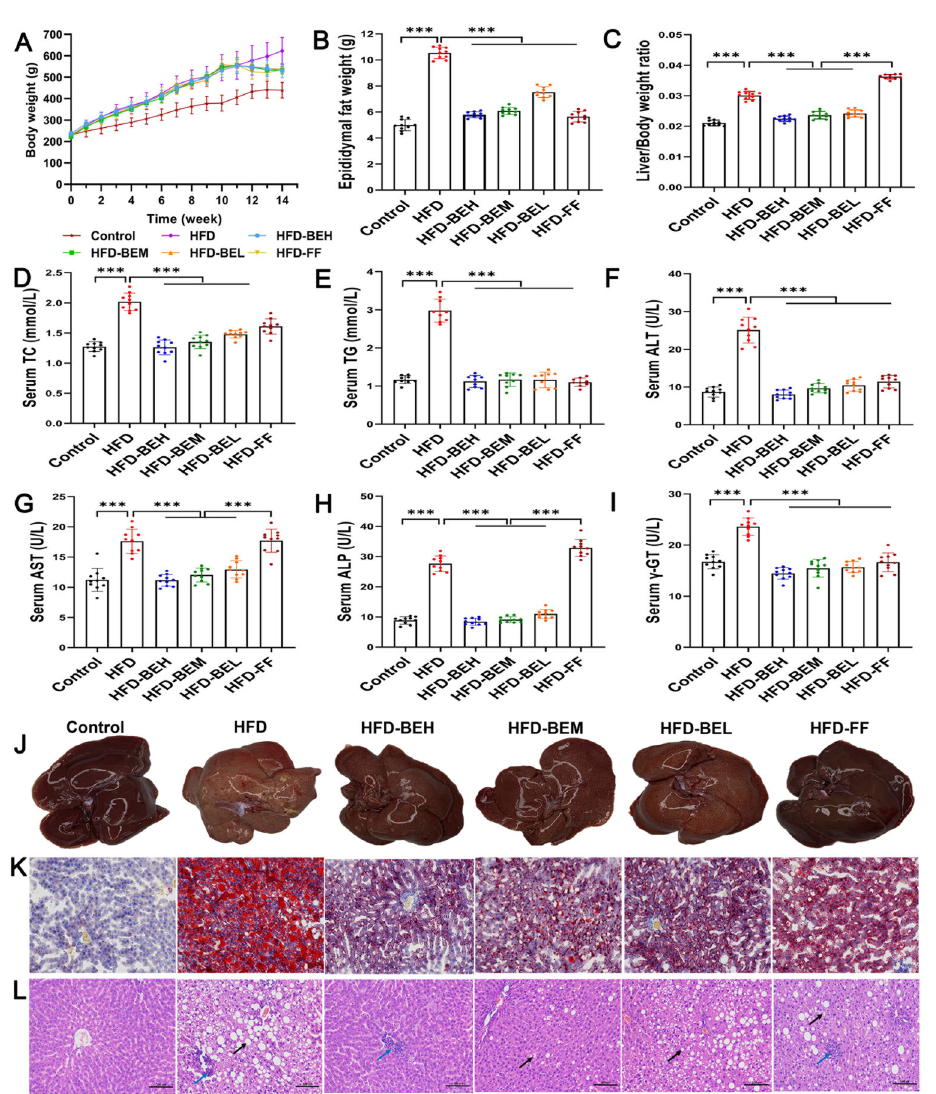
weights, and ( C ) liver/body weight ratio. Serum levels of ( D ) triglyceride (TC), ( E ) total cholesterol (TG), ( F ) alanine aminotransferase (ALT), ( G ) aspartate aminotransferase (AST), ( H ) alkaline phosphatase (ALP), and ( I ) g -glutamyl transferase ( g -GT). J , Representative macroscopic images of livers; K , Oil-Red-O staining; and L , hematoxylin and eosin (HE) staining images of the liver (magni fi cation: 200 (cid:2) , scale bar: 100 m m). The black arrows represent circular vacuoles; the blue arrows represent in fl ammatory cell in fi ltration. Data are reported as means ± SD. ***P o 0.001 (one-way